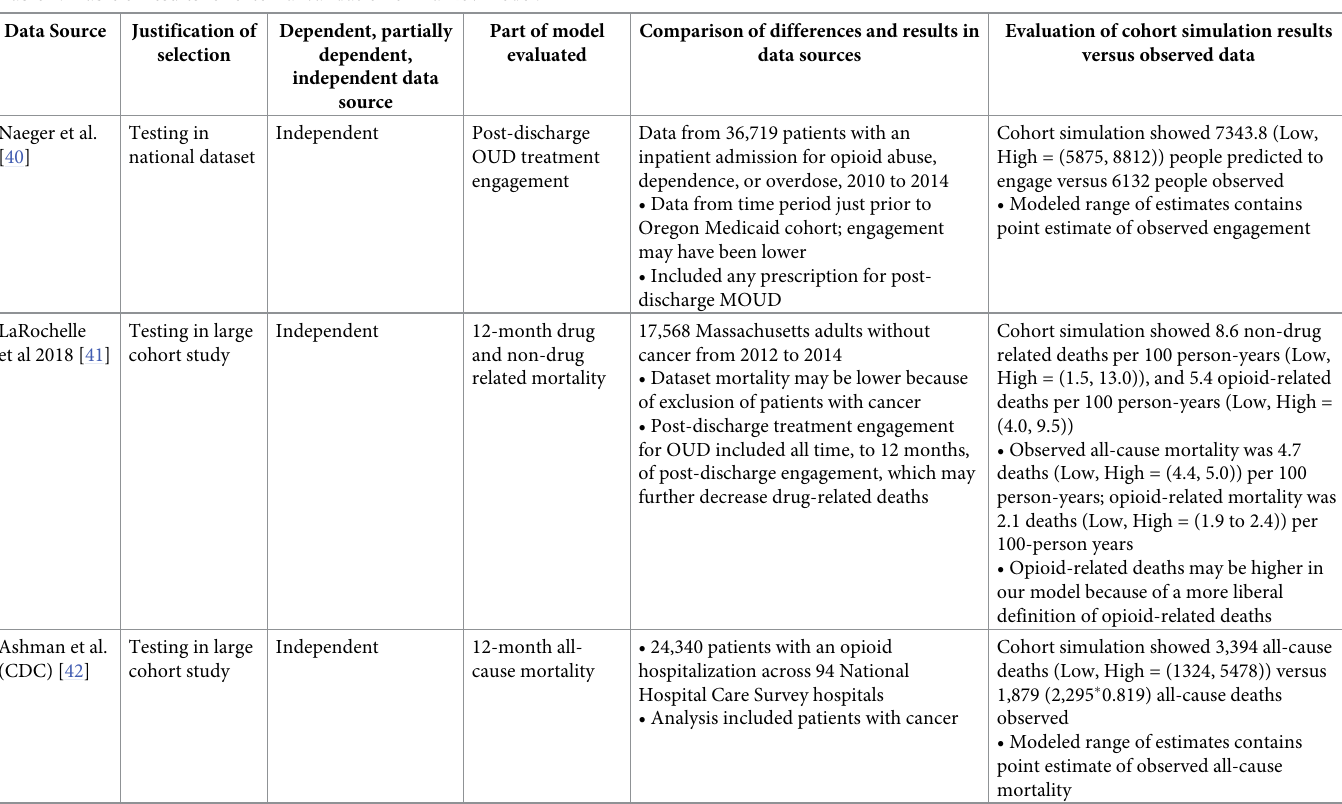
Table 2. Table of results for external validation of Markov